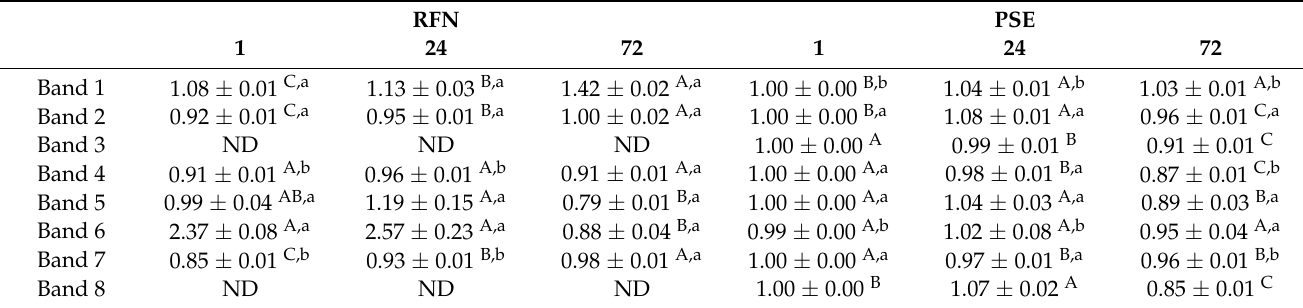
Table 2. Band intensities of representative myofibrillar protein among the pale, soft and exudative (PSE), and red, firm and non-exudative (RFN) groups during the postmortem aging.